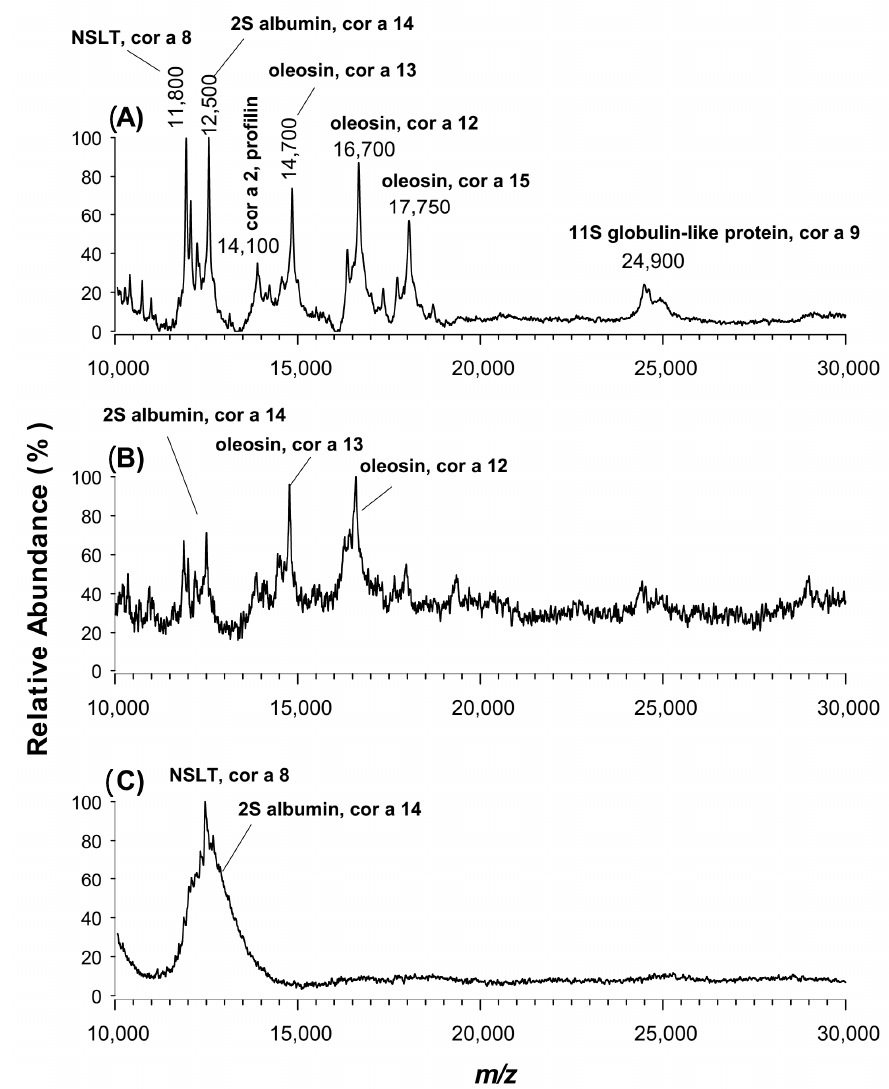
Figure 6. Positive MALDI-TOF MS spectra of the extract of hazelnut proteins mixed with ( A ) CPPA, ( B ) CHCA or ( C ) CClCA as the matrix. The identified proteins are labelled in the subfigures, NSLP (Non-specific lipid transfer protein).